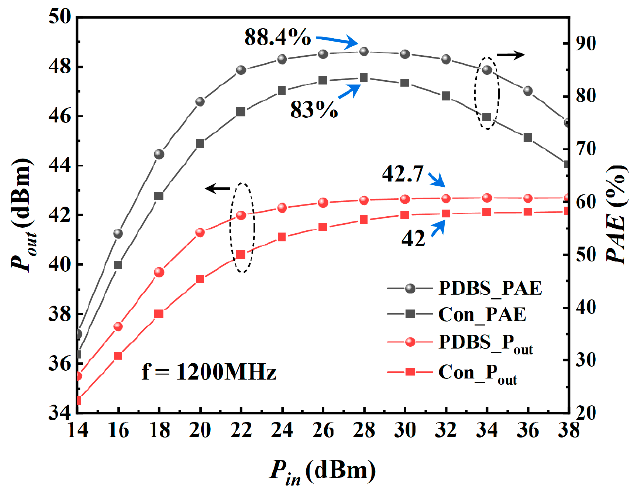
Figure 10. Large-signal performance of both structures at 600 MHz with V gs = − 4 V, V ds = 20 V.